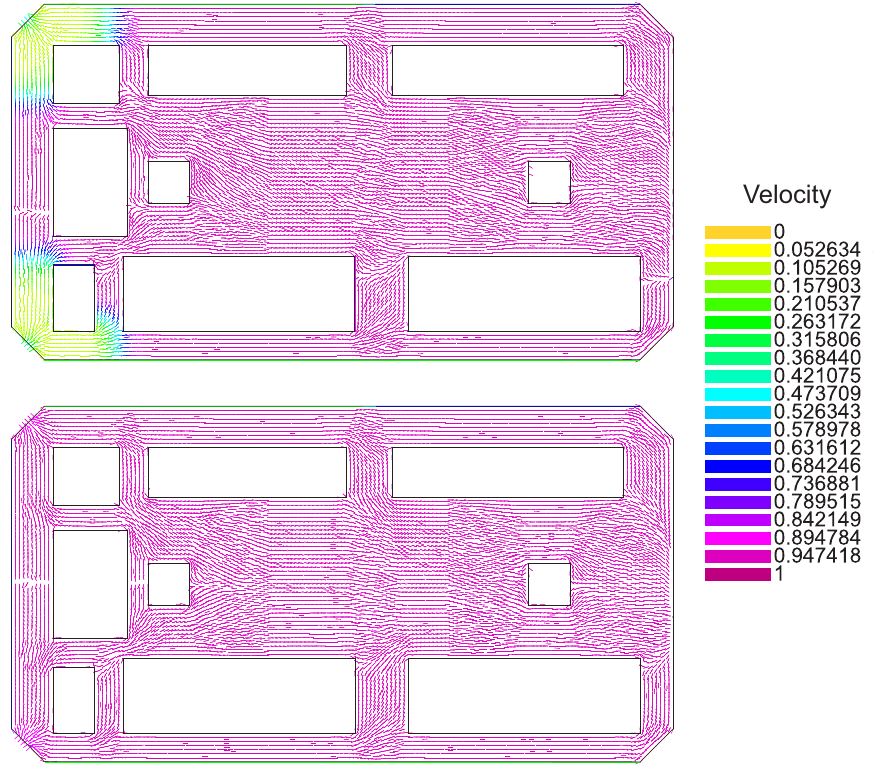
Figure 5. Case 1: Normalized pedestrian velocities u / u max at final time t = 350 for the initial ( top ) and the optimal locations ( bottom ) of exit doors (shown by outward arrows on the boundary).